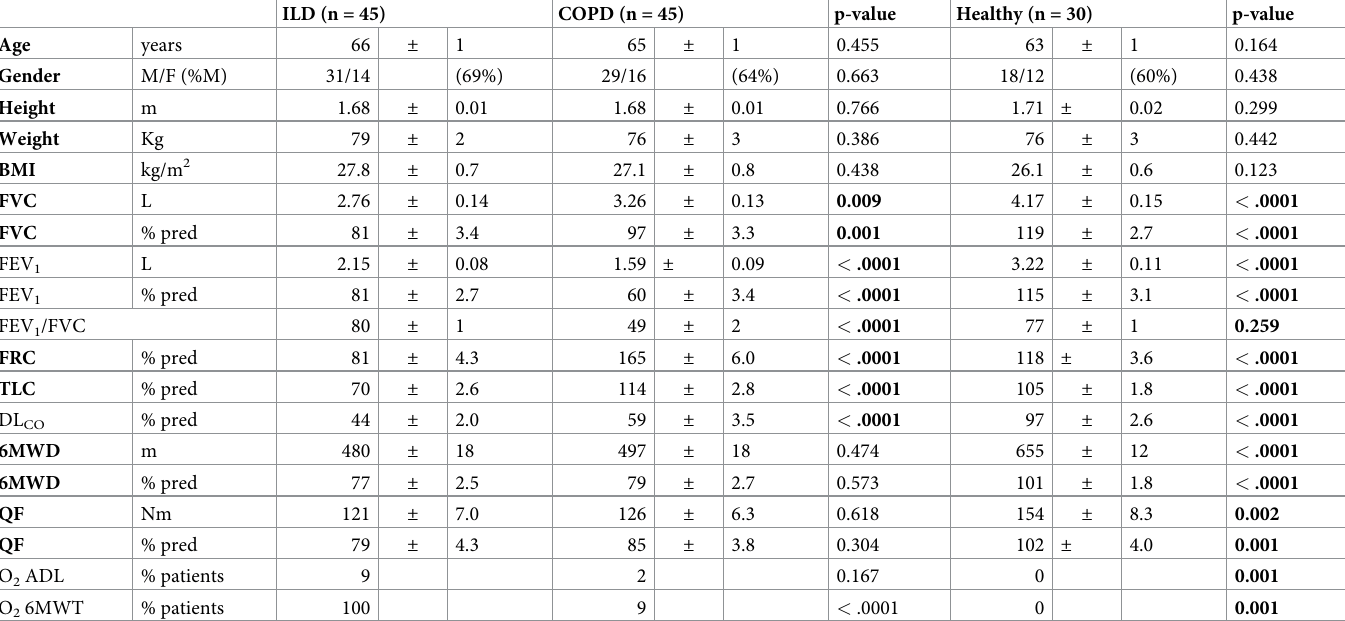
Table 2. Patient characterization after propensity matching